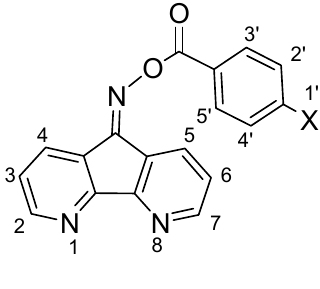
Table 3. The characteristic 1 H-NMR absorptions for compounds 7a – d a